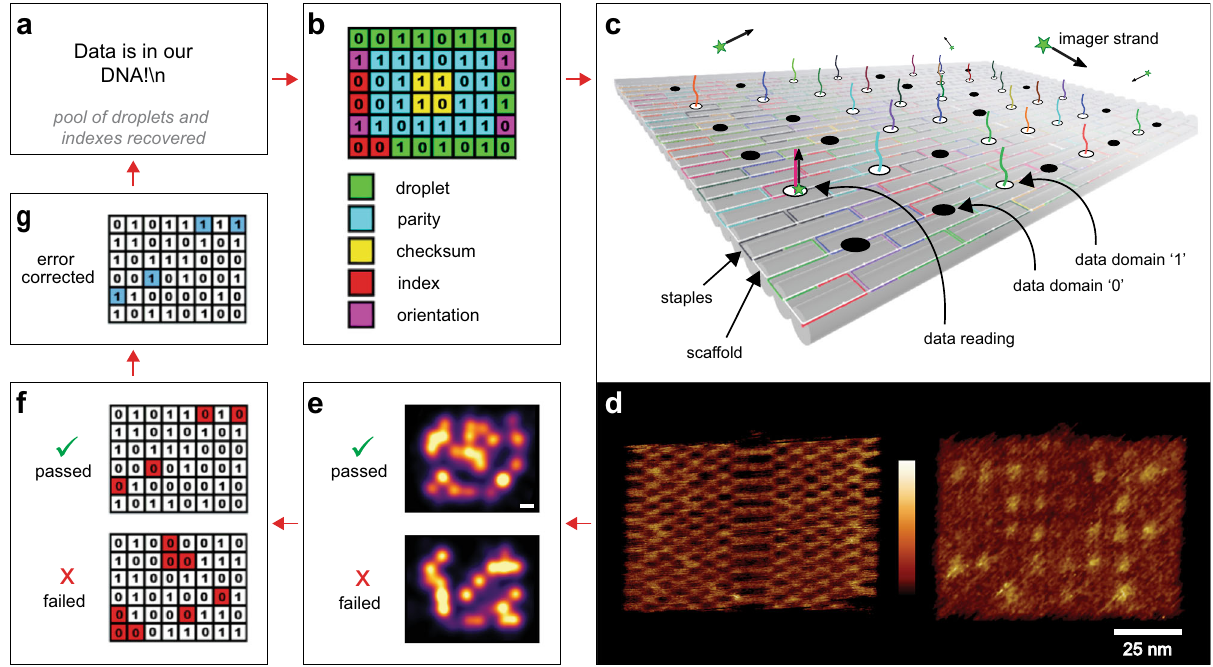
Fig. 1 Binary dNAM overview. The test message ( a ) for optically reading dNAM was ‘ Data is in our DNA! ’ . The message was encoded and then synthesized into 15 dNAM origami. For clarity, only one of the 15 designs is shown in ( b ). The data domain colors correspond to their bit values as follows: droplet (green), parity (blue), checksum (yellow), index (red), and orientation (magenta). Site-speci fi c localization is enabled by extending or not- extending the structural staple strands of the origami to create physical representations of 1s and 0s. The presence, absence, and identity of a data strand ’ s docking sequence de fi nes the state of each data strand and is assessed by monitoring the binding of data imager strands via DNA-PAINT in ( c ). AFM images of an origami nanostructure are depicted in ( d ), with both the expected raft honeycomb structure (left) and data strands (right) visible. The scale bar is 25 nmin the AFM images and the color scale ranges from 0 – 1 nm in height. To ‘ read ’ the encoded message, 4 μ L of the DNA origami mixture, containing 0.33 nM of each origami, was imaged via DNA-PAINT. Two representative origami cropped from the fi nal rendered image are shown in ( e ), scale bar, 10 nm. All structures identi fi ed as origami in the rendered image were converted to a matrix of 1 ’ s and 0 ’ s corresponding to the pattern of localizations seen at each data domain in ( f ). The red boxes in ( f ) now indicate errors. The decoding algorithm performed error correction where possible in ( g ) and successfully retrieved the entire message when suf fi cient data droplets and indexes were recovered in ( a ). The blue boxes in ( g ) now indicate corrected